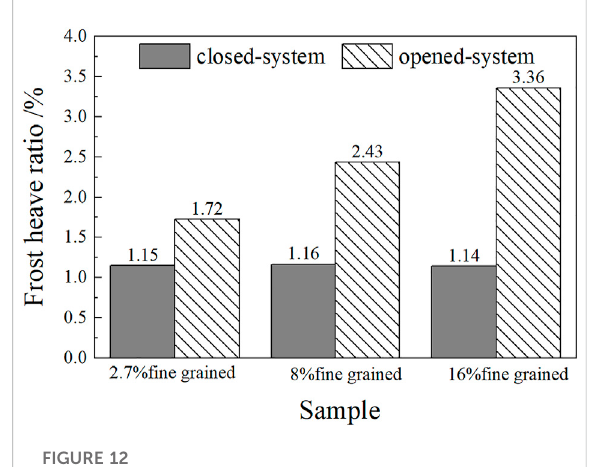
FIGURE 11 Frost heave ratio of samples under different moisture contents.